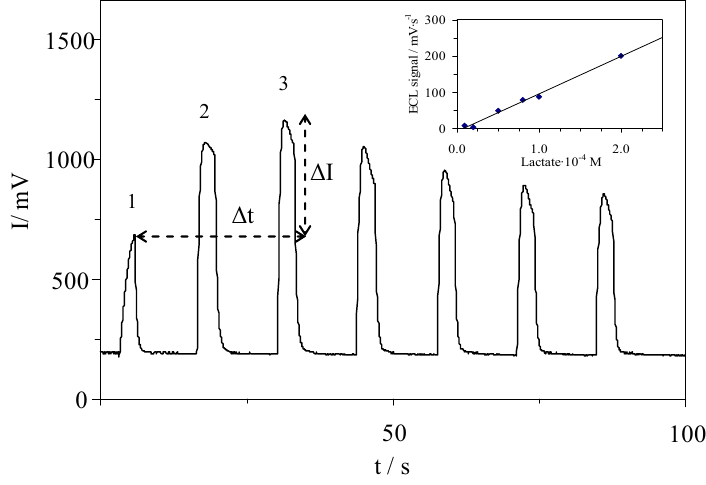
Figure 6. Luminol ECL emission at lactate 10 − 4 M in chronoamperometric mode (0.5 V). Lactate linear calibration is presented in the inset.